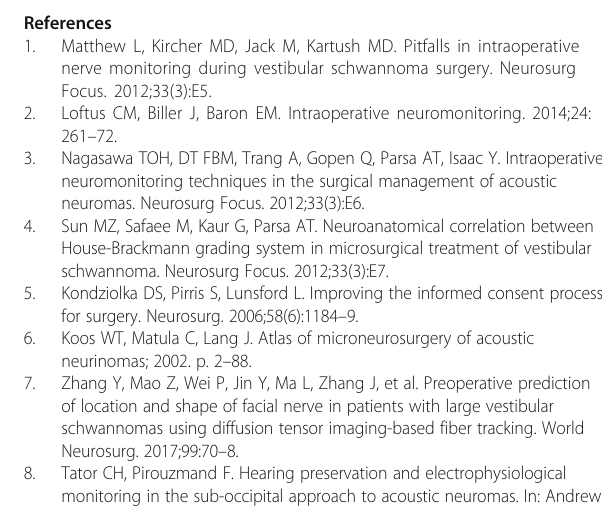
Table 5 Relation between the consistency of the neoplasm and functional preservation of the facial nerve Consistency of tumor